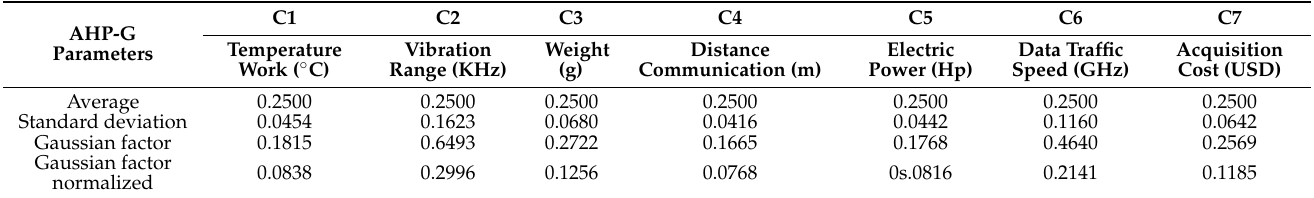
Table 8. Average criteria—Standard deviation—Gaussian factor—Step 2, 3 and 4.